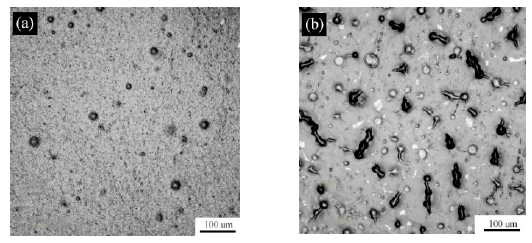
Figure 6. Morphology of studied coatings ( a ) coating 5011 ( b ) coating 5012.